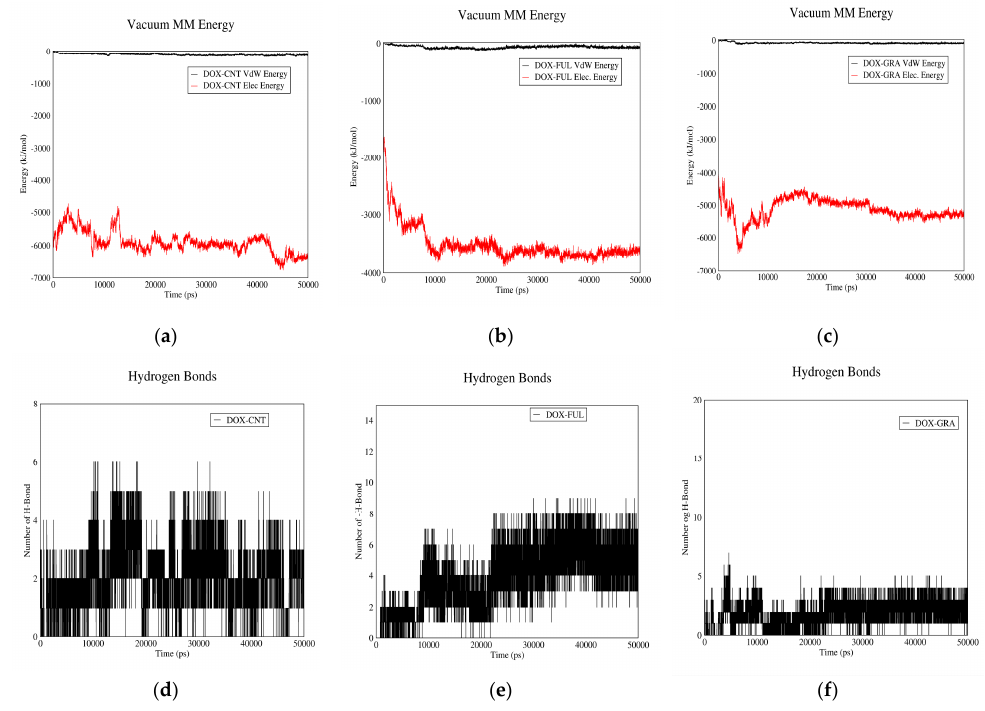
Figure 9. DOX–Carrier interaction energies and hydrogen bonds in neutral pH: ( a ) electrostatic and Van der Waals energies of DOX–CNT interaction versus time in neutral pH; ( b ) electrostatic